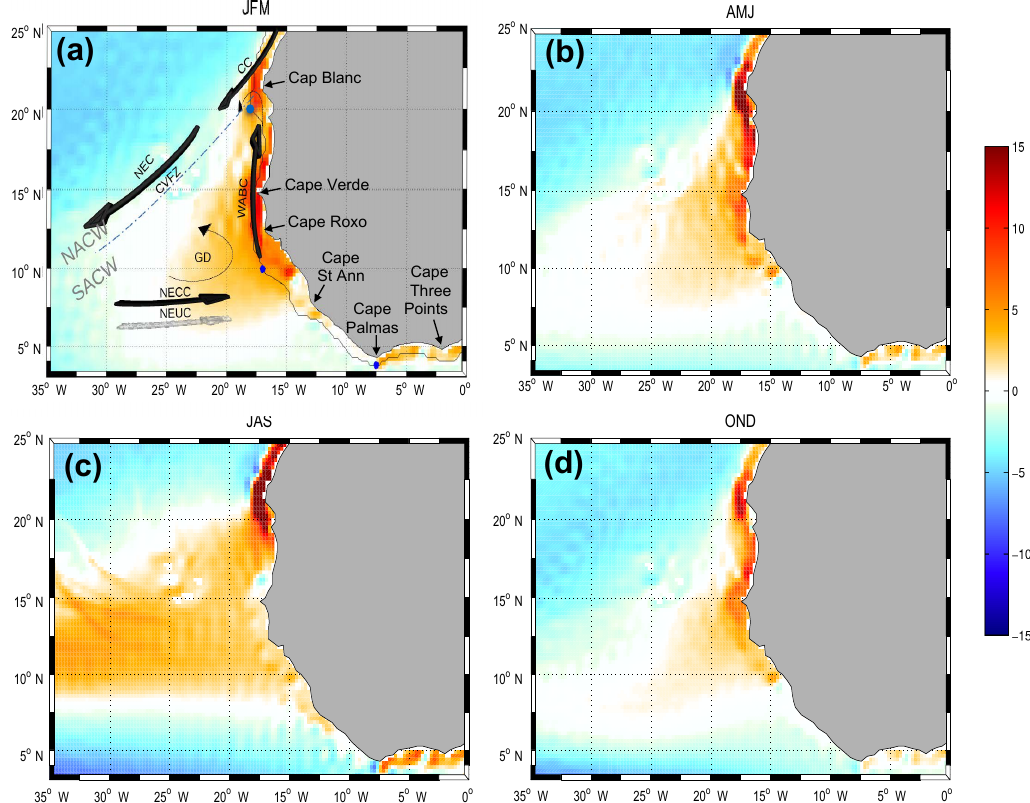
Figure 1. Seasonal climatology of Sverdrup transport (m 2 s − 1 ; excluding the Ekman flow in the surface layer) computed from the DFS5.2 wind forcing fields averaged for January–March (a) , April–June (b) , July–September (c) , and October–December (a) . The main regional flow, thermohaline features, and capes are indicated in panel (a) : the Canary Current (CC), North Equatorial Current (NEC), North Equatorial Counter Current (NECC), north Equatorial Undercurrent (NEUC), Guinea dome (GD), and Cape Verde frontal zone (CVFZ), which separates the realm of the North Atlantic Central Waters (NACWs) and South Atlantic Central Waters (SACWs). The TROP025 100m isobath along which several analyses are made is shown in black. Three geographical limits used to define the integrated upwelling indices computed in Sect. 5 are shown with blue